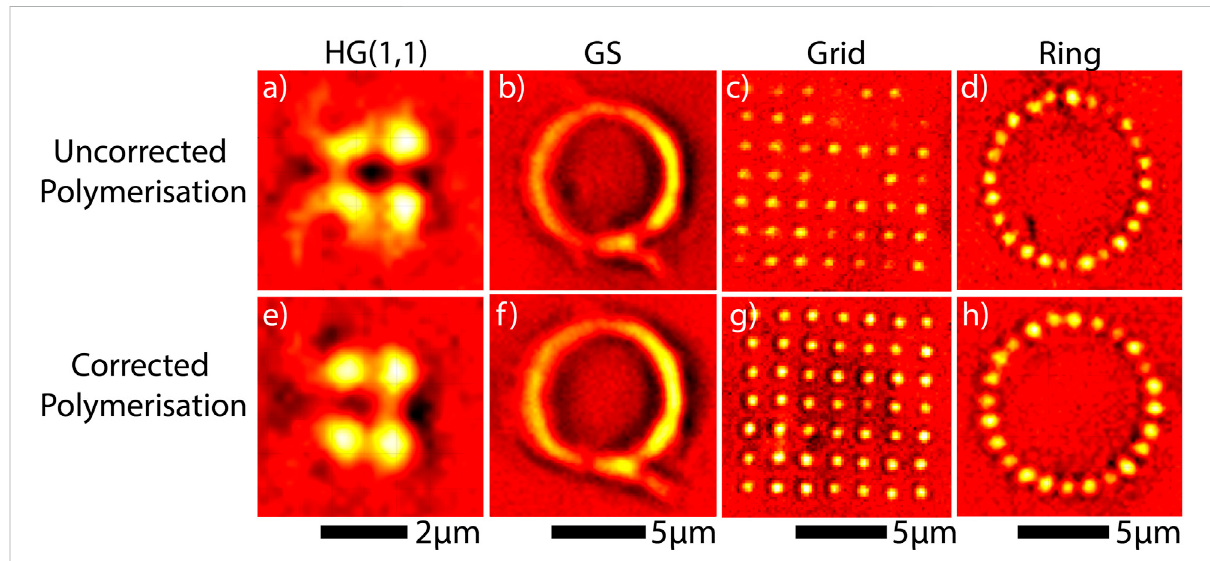
FIGURE 6 False-colour CMOS camera images of polymerisedstructures printed ontoamicroscope coverslip using theuncorrected (A – D) and corrected (E – H) beam, utilising the in-situ phase correction shown in Figure 3 (B) . (A , E) HG(1,1) mode, (B , F) Letter “ Q ” fabricated by rapidly displaying 50 phase patterns generated though the Gerchberg-Saxton algorithm. (C , G) Single-pass exposure of a 7 × 7 grid with side length 10 μ m, generated with the aforementioned optimised Gerchberg-Saxton algorithm (Di Leonardo et al., 2007). (D , H) 35 equidistant foci forming a ring with radius 5 μ m, fabricated in a single